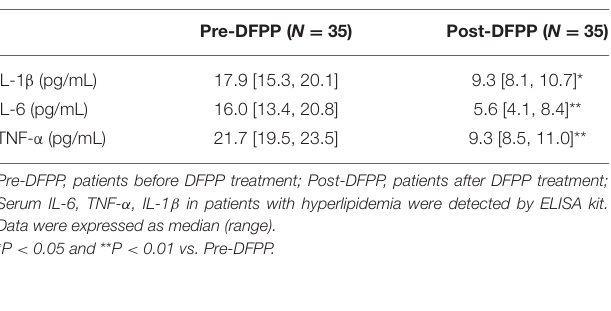
TABLE 2 | DFPP reduces inflammation